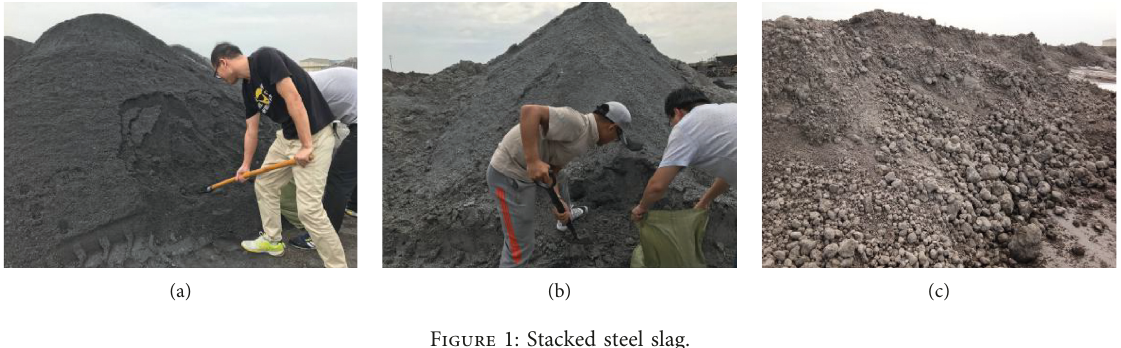
Figure 1: Stacked steel slag. Table 1: Particle contents in different grain size groups of three kinds of steel slag (%). Materials